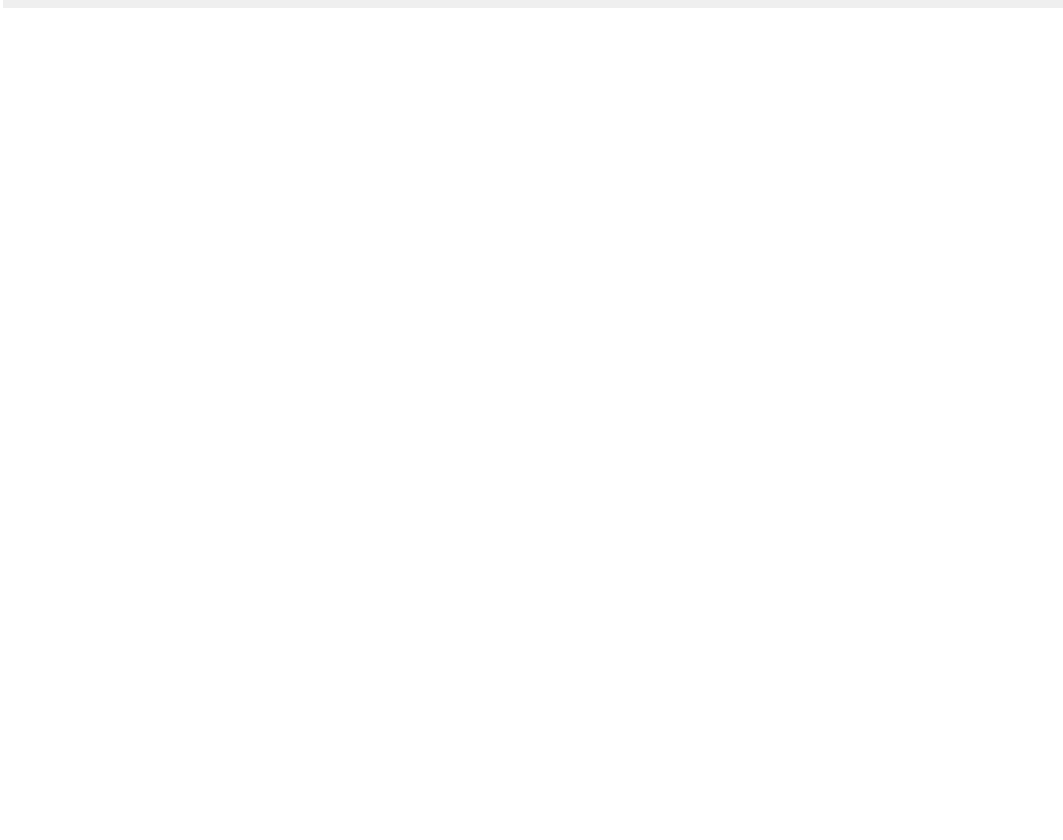
Figure 4 Number of studies included in Cochrane